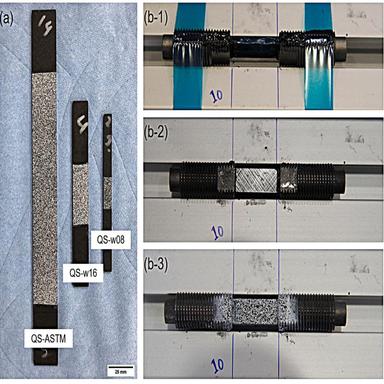
Images of ± 45◦ tensile specimens for in-plane shear testing: (a) for quasi-static testing; and (b) sample preparation steps for dynamic testing at intermediate strain rates using adhesive clamping technique.